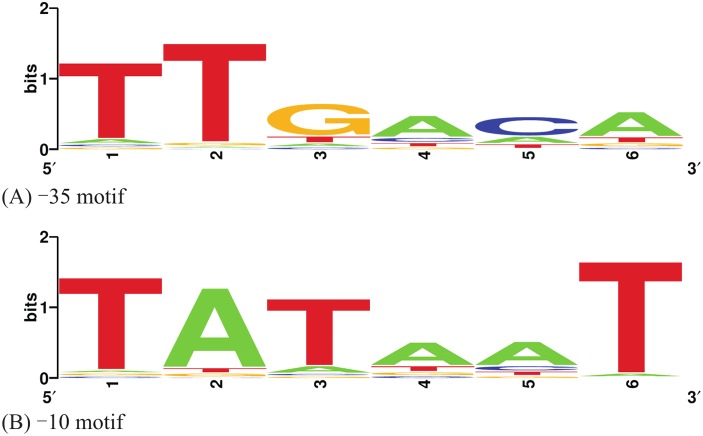
Sequence logos of the −35 and −10 hexamers of the selected RegulonDB promoters.(A) −35 motif; (B) −10 motif. Figure was made using WebLogo (Crooks et al., 2004).